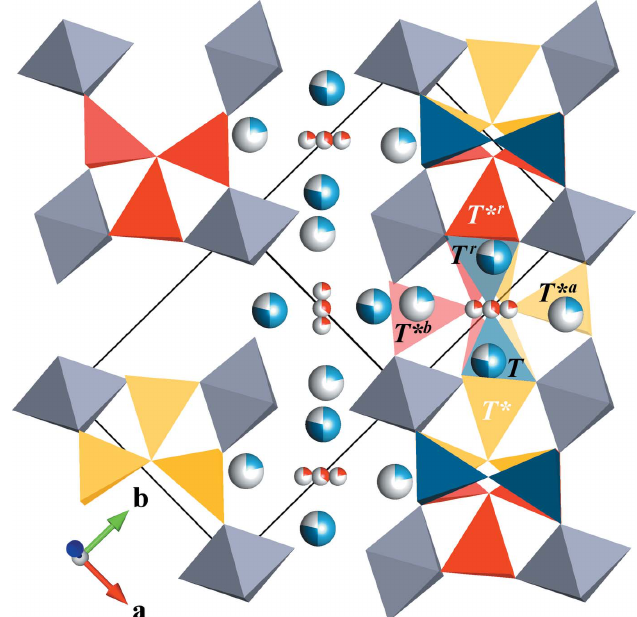
Figure 3 An average structure model of mullite with split sites and its decomposition into diclusters and triclusters. Unit-cell borders are marked by black lines. The fractional occupancy of each site is indicated by the filling of the sphere that represents the atom. A vacancy requires that all cation sites with black labels and the central oxygen sites are simultaneously vacant, and that two triclusters are present next to it, as shown on the left-hand side of the model.